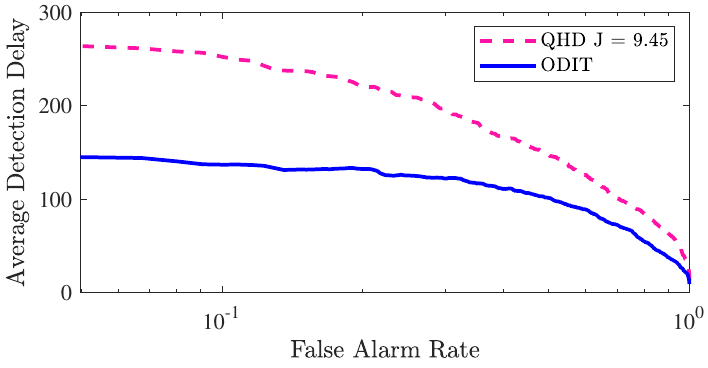
Figure 8. Performance evaluation for ODIT and QHD in the correlation monitoring example in terms of average detection delay vs. false alarm rate